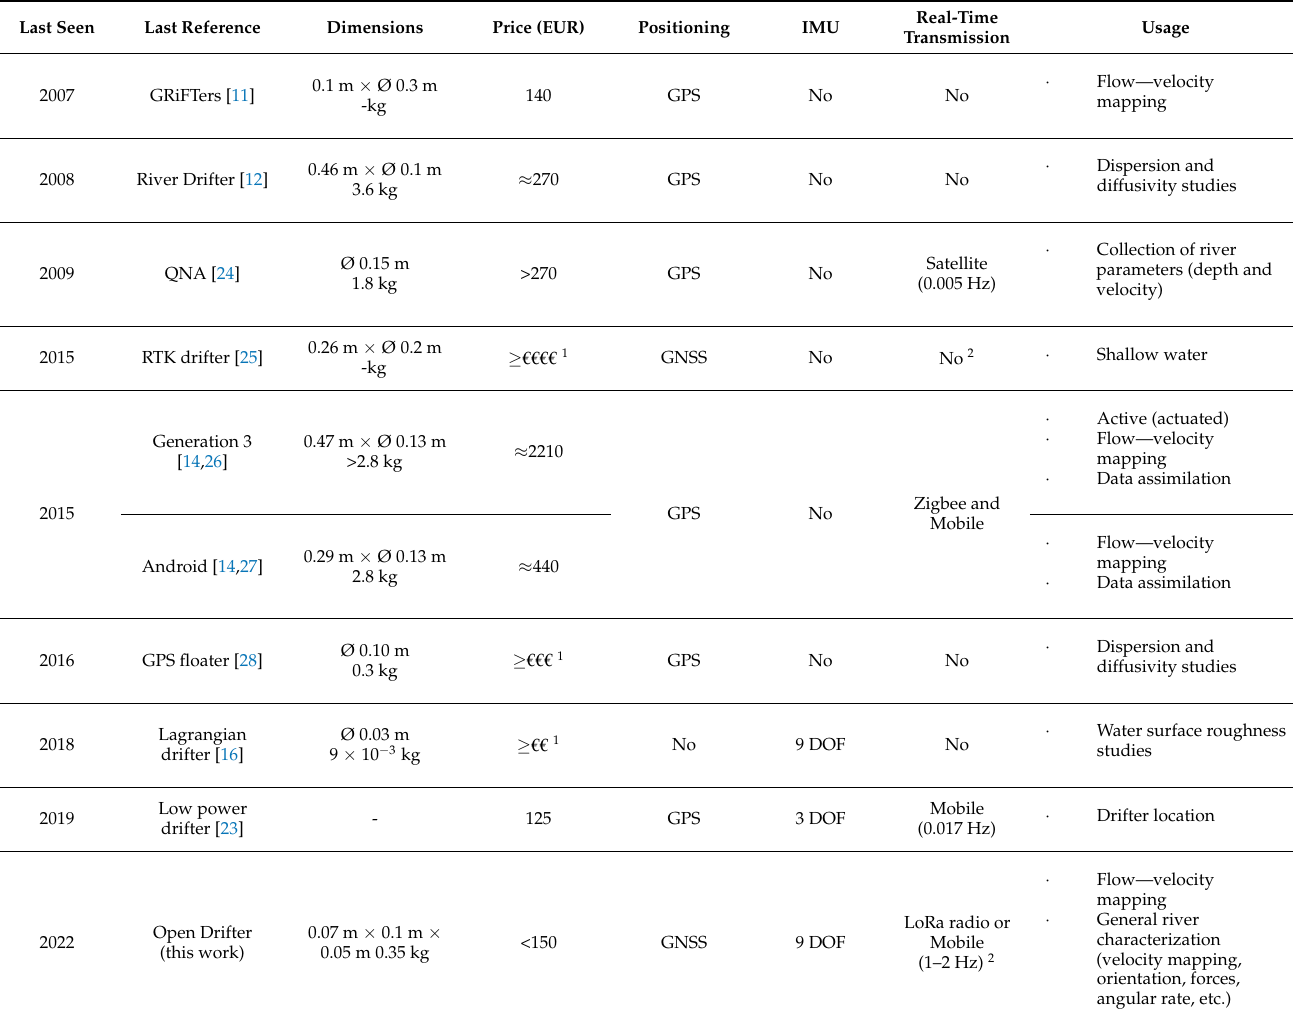
Table 1. Summary of relevant drifters for river applications developed during recent years (up to 2020) and their main characteristics. IMU means Inertial Measurement